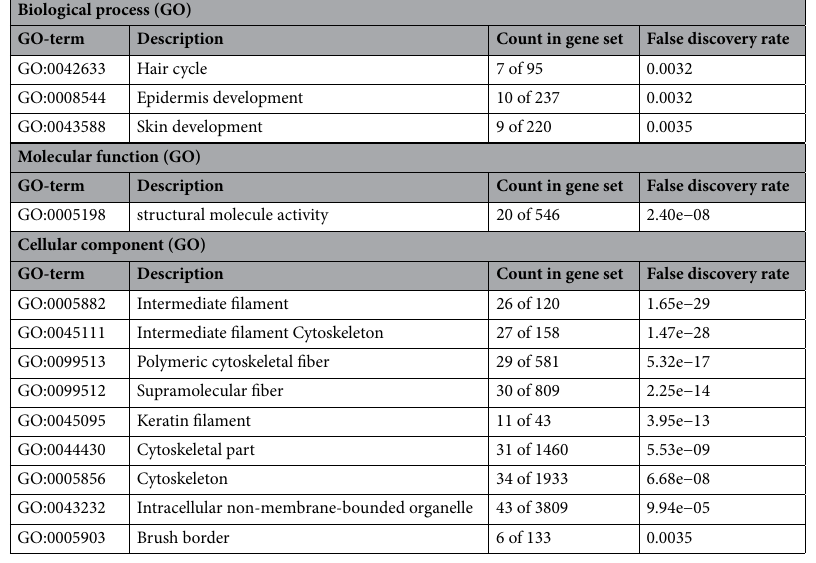
Table 2. GO-terms enrichment of differentially expressed genes after PBS irradiation.